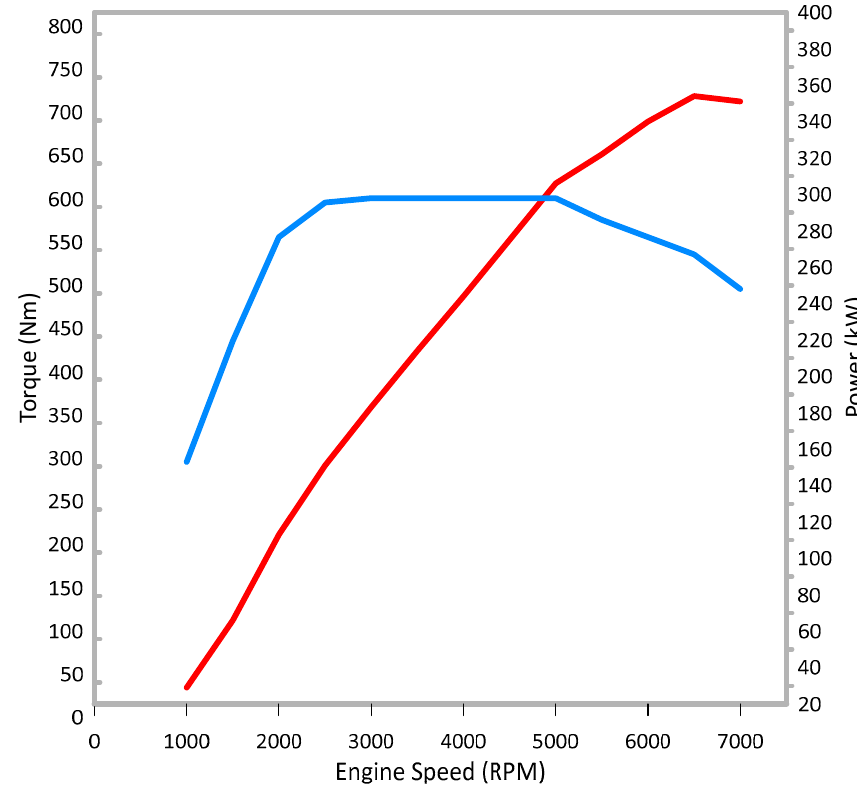
Figure 5. Power (red line) and torque (blue line) curve of i.c. engine.